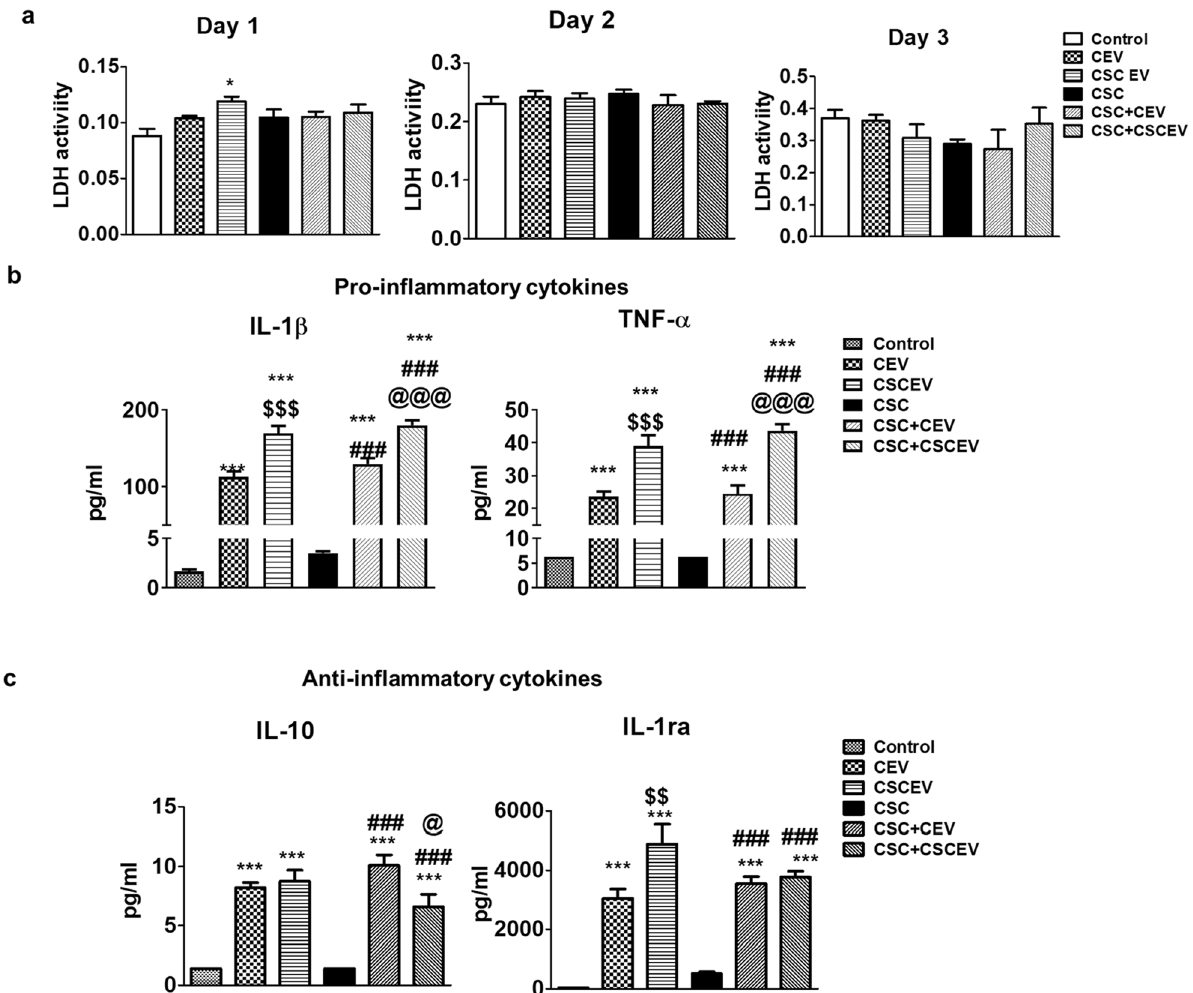
Figure 2. Effect of EVs derived from HIV-uninfected U937 macrophages on cytotoxicity and modulation of cytokines in SVGA cells. The EVs were isolated from U937 macrophages exposed to CSC (10 µg/ml) once daily for 7 days. SVGA cells (0.3 million cells/well/12 well plate) were treated with CSCEV once daily for three days. After three days of treatment, the lactate dehydrogenase (LDH) ( a ) was measured in the supernatant every day, and cytokines were measured on day 3 samples ( b & c ). One-way ANOVA with Tukey’s multiple comparison test was used to find the significance among the groups. CEV represents EVs isolated from the control group; CSCEV represents EVs isolated from the CSC-treatment group. *, ** and *** represent p < 0.05, p ≤ 0.01, and p ≤ 0.001 respectively when compared to control; #,##, and ### represents p < 0.05, p ≤ 0.01, and p ≤ 0.001 respectively when compared to CSC; $,$$, and $$$ represents p < 0.05, p ≤ 0.01, and p ≤ 0.001 respectively when compared to CEV; @@@ represents p ≤ 0.001 when compared CSC + CEV vs CSC +